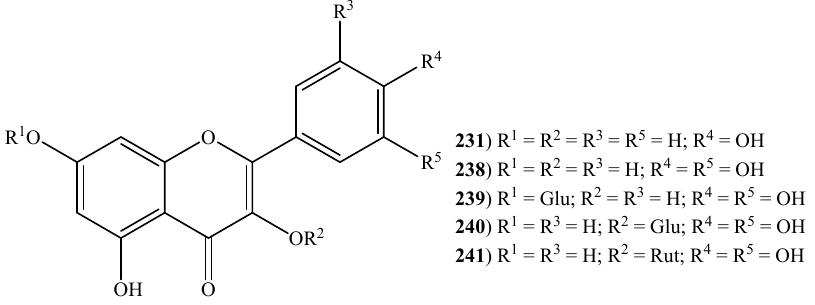
Figure 7. Some flavonols and derivatives reported in halophytic grasses (Glu = D-glucose; Rut = rutinose) (see Table S1).